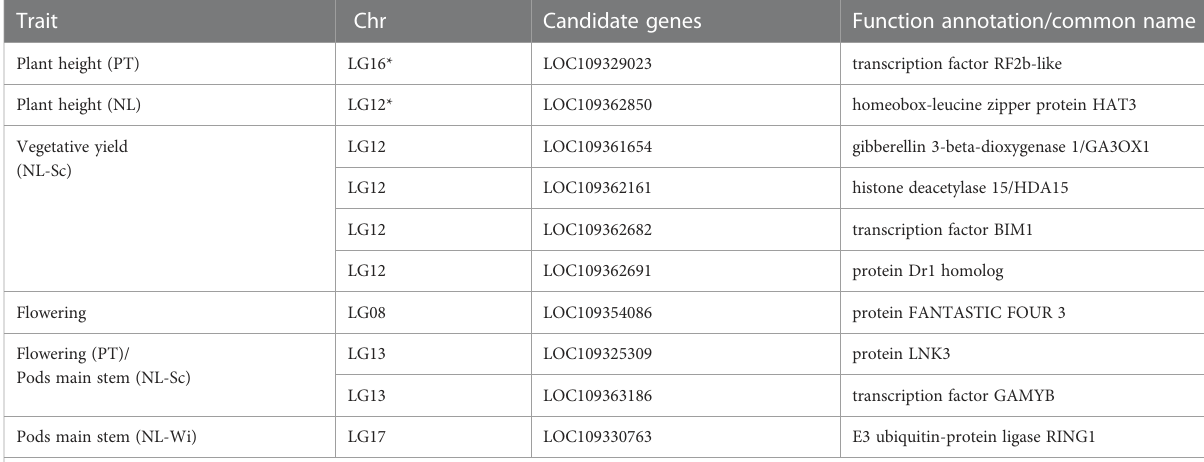
TABLE 3 Functional annotation of ortholog genes proposed as potential candidate genes for plant architecture and yield-related traits in L. mutabilis .